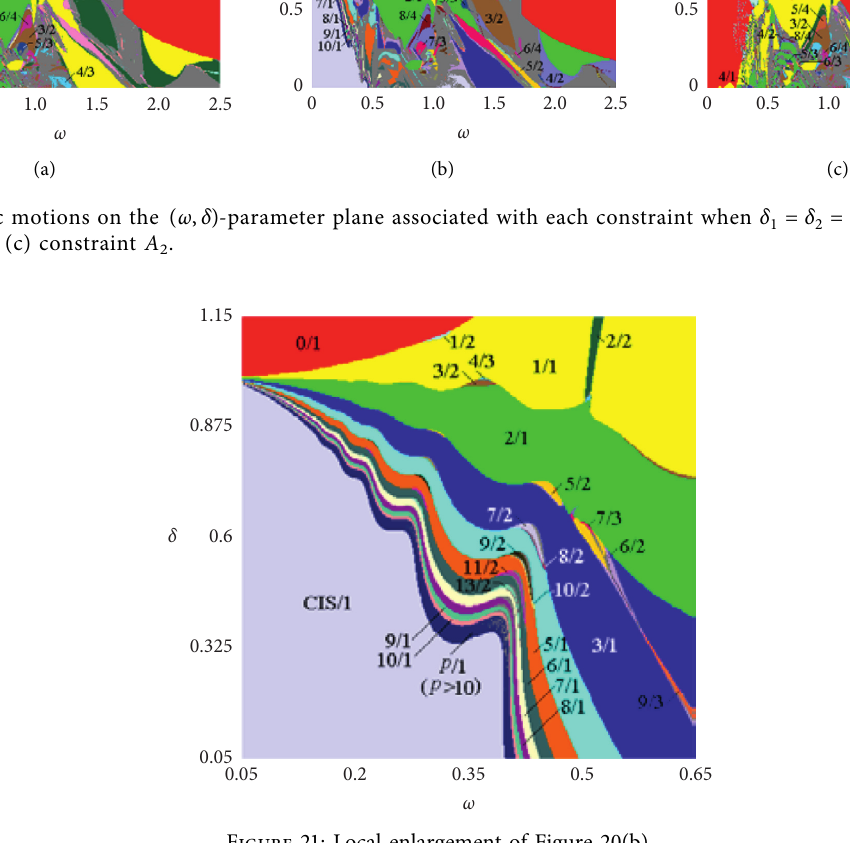
Figure 21: Local enlargement of Figure